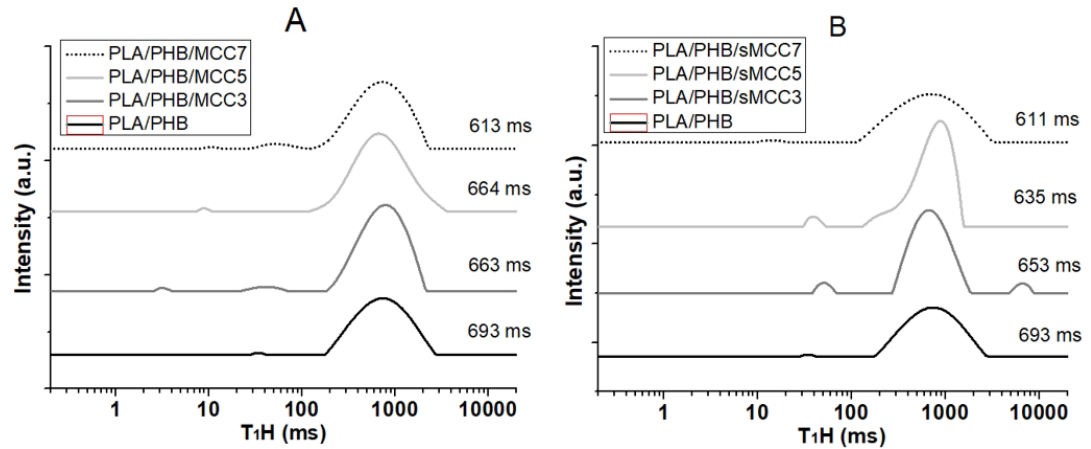
Figure 8. Distribution domain curves for the PLA/PHB biocomposite systems with (A) MCC and (B)